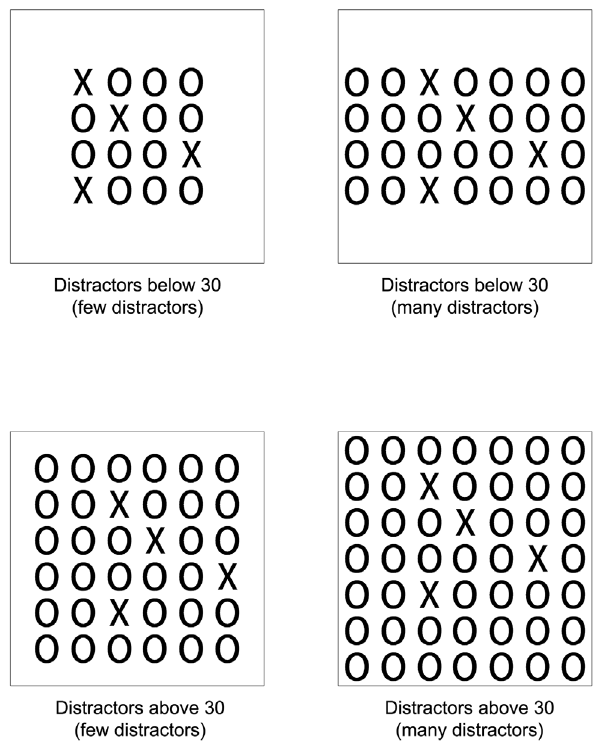
Figure 4. Examples of organized displays in the various conditions in Experiment